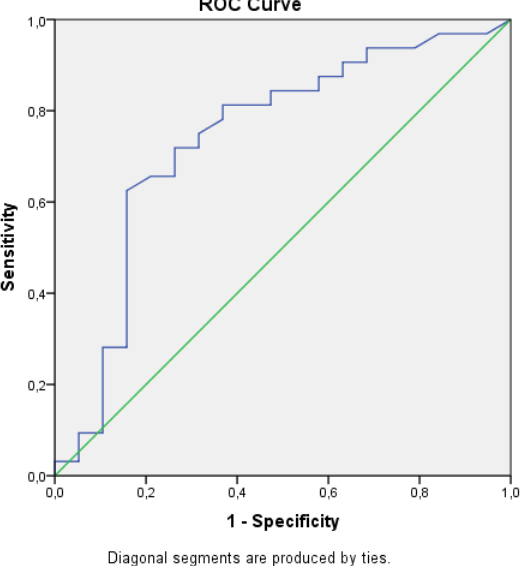
Fig. 5. ROC analysis of the pNfL of patients with and without BVL. The sensitivity and specificity of the predictive model were 96.6% and 68.2%, respectively, with a cut-off level of 8.25 pg/ml for NfL, and an area under curve (AUC) of 0.909 (95% CI: 0.815–1.0; P <0.001). Higher pNfL values indicate stronger evidence for the presence of BVL. AUC, Area under the curve; BVL, Brain volume loss, NEDA- No evident disease activity; pNfL, plasma neurofilament light chain; ROC, Receiver operating